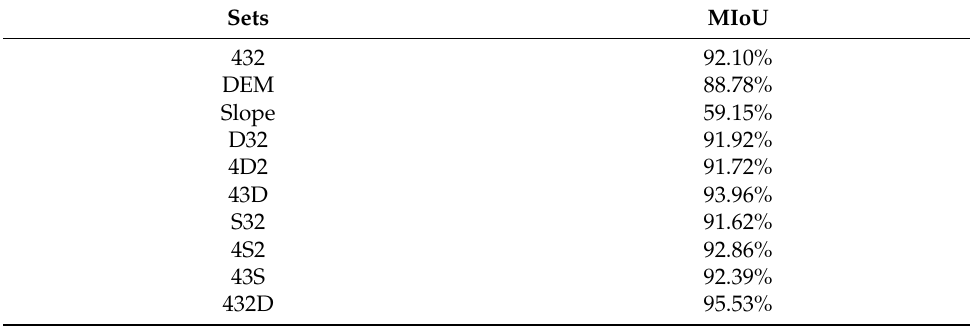
Table 2. MIoUs of different samples used for training the DeepLab V3+